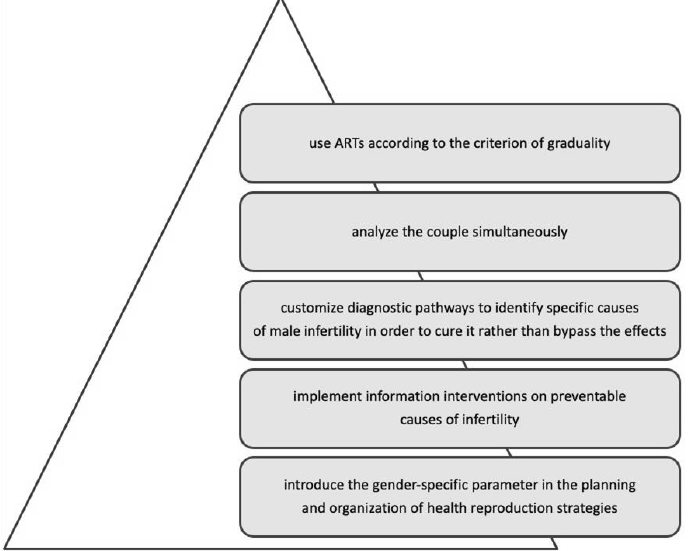
Figure 3. Crucial points of intervention for improving couple infertility management with a gender- oriented approach.